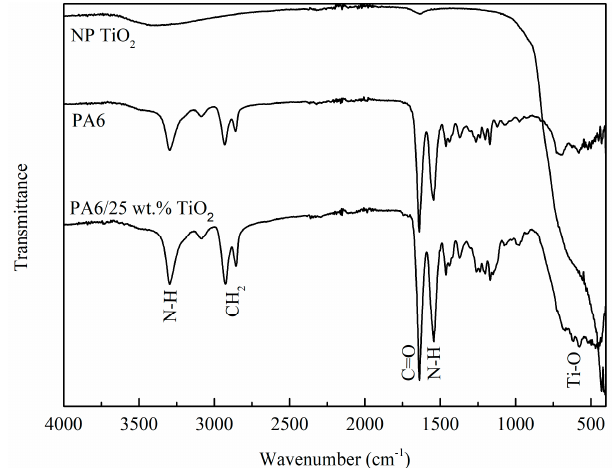
Figure 1. FTIR spectra of TiO 2 nanoparticles, PA6 electrospun nanofibres and PA6 / 25 wt.% TiO 2 electrospun nanofibres.